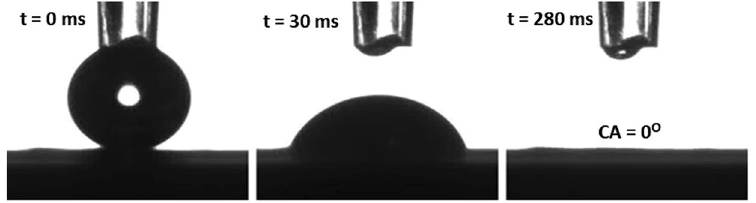
Figure 2. Quick spreading process of a water droplet of 4 µ L into the MWCNT-MnO 2 membrane.